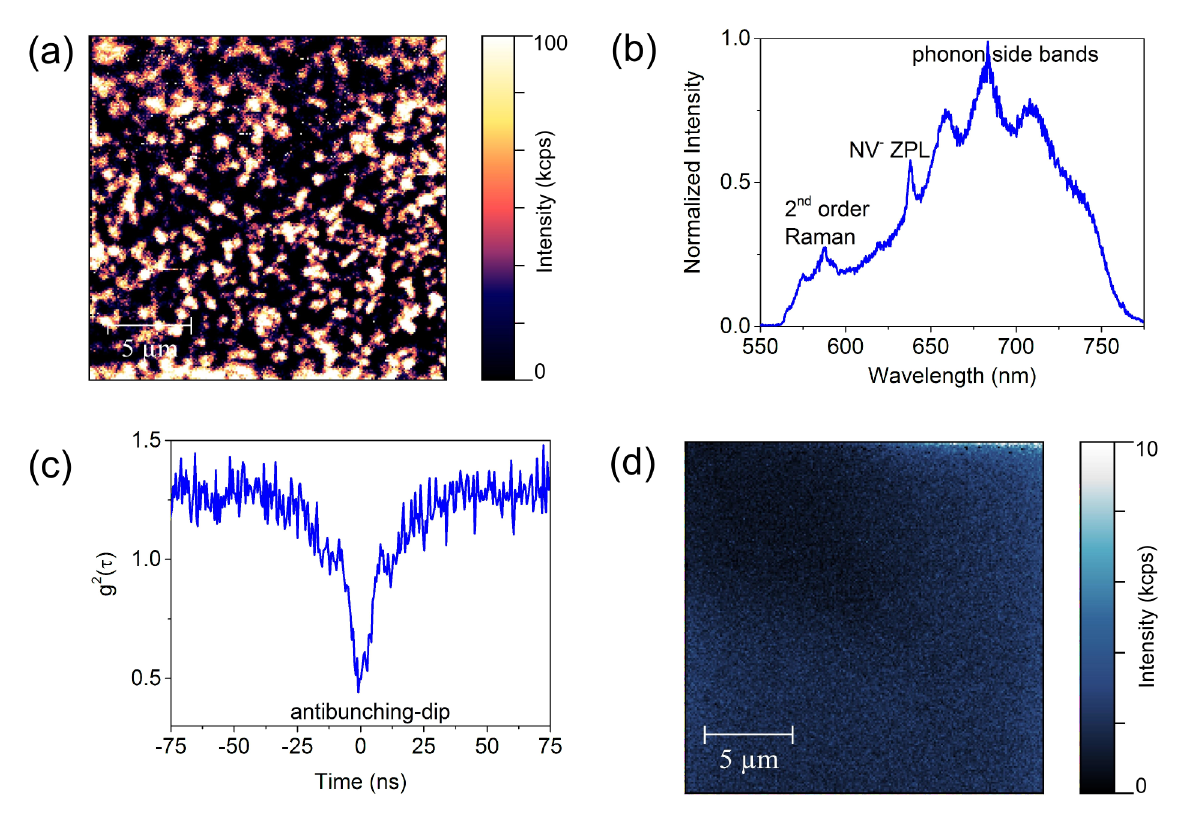
Figure 1: Formation and quenching of NV centres. (a) PL-intensity mapping performed on the diamond surface which shows bright spots. These bright spots are single NV − centres according to the corresponding (b) PL-spectrum and (c) second-order photon autocorrelation measurement per- formed with a Hanbury–Brown and Twiss interferometer setup showing a clear antibunching dip indicating single photon emission. (d) After H-termi- nation of the diamond surface the NV-emission is quenched due to the conversion from the fluorescent state NV − to NV + , i.e., only a PL-background of the surface is